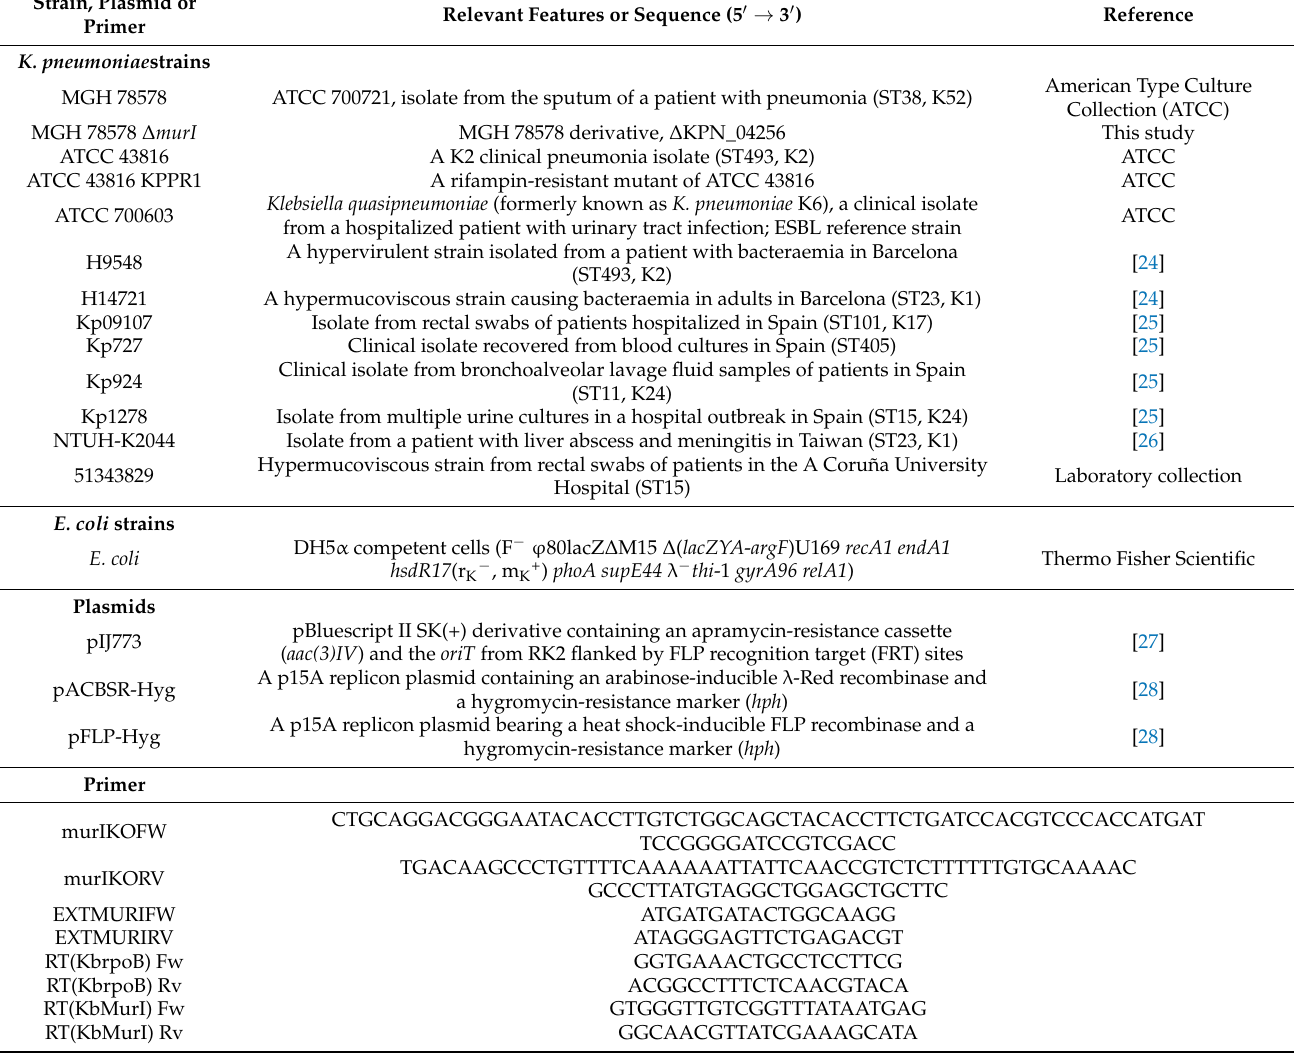
Table 1. Bacterial strains, plasmids and primers used in this